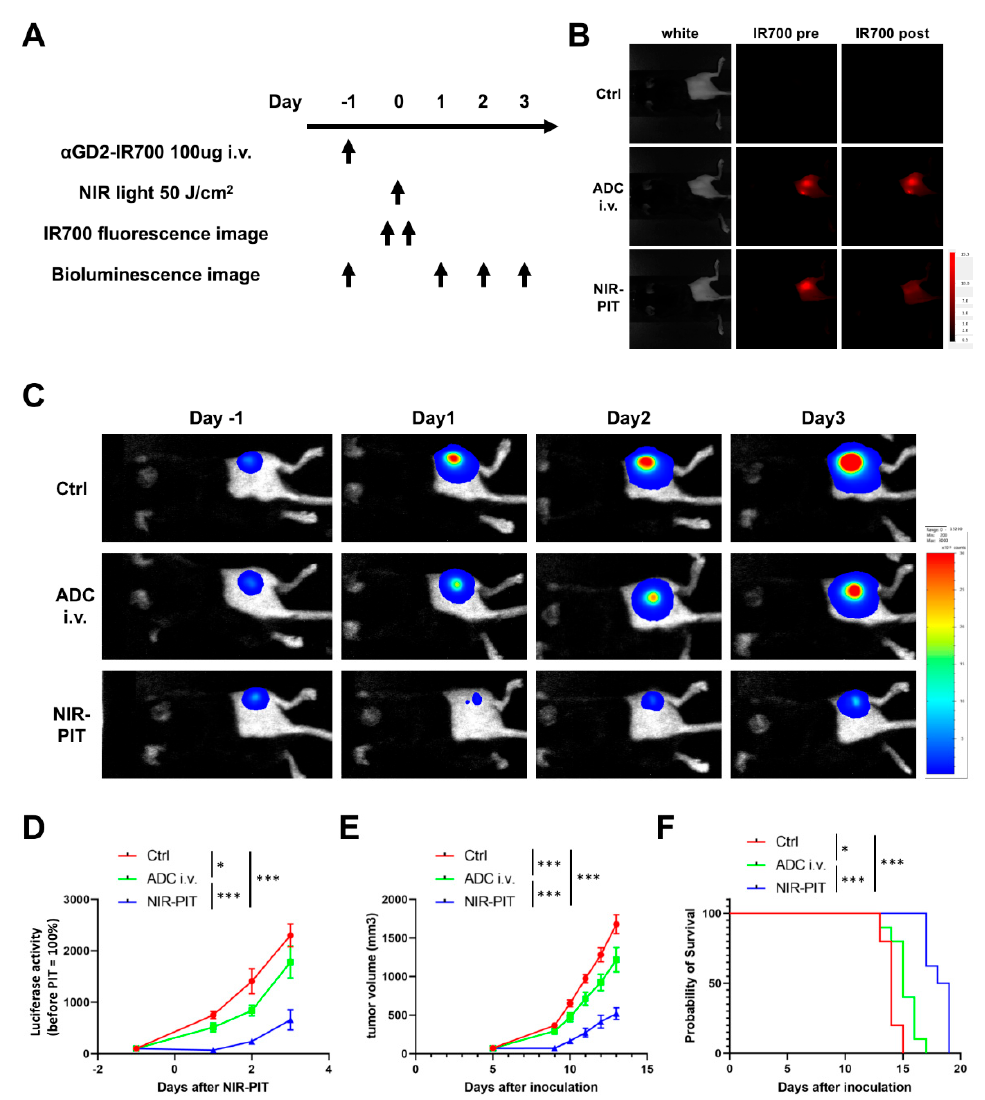
Figure 3. In vivo tumor response of GD2-targeted NIR-PIT. ( A ) Treatment regimen and imaging study protocol. ( B ) Representative IR700 fluorescence images of mice with EL4-luc tumor before and after GD2-targeted NIR-PIT. ( C ) Representative bioluminescence images of mice with EL4-luc tumor. ( D ) Quantitative analysis of changes in luciferase activity in EL4-luc tumors (values before treatment were set to 100%; n = 10 animals per group; two-way repeated measures ANOVA fol- lowed by Tukey’s multiple comparison test; * p < 0.05, *** p < 0.001). ( E ) Tumor growth curves (n = 10 animals per group; two-way repeated measures ANOVA followed by Tukey’s multiple compar- ison test; *** p < 0.001). ( F ) Survival curves (n = 10; log-rank test followed by Bonferroni correction; * p < 0.05, *** p < 0.001). 3.5. Histological Changes and Activated Antitumor Host Immunity after GD2-Targeted NIR- PIT For histological analysis of tumors after GD2-targeted NIR-PIT, tumors were excised a day after NIR-PIT. Formalin-fixed paraffin-embedded sections of excised tumors were stained with hematoxylin and eosin. Although tumors in the Ctrl group and ADC i.v. group showed no obvious histological change, tumors in the NIR-PIT group showed dif- fuse necrosis and microhemorrhage. Next, we evaluated the activation of antitumor host immunity after GD2-targeted NIR-PIT. Regional lymph nodes (ipsilateral inguinal lymph nodes) were harvested 1 day after NIR-PIT and analyzed by flow cytometry. CD69 and